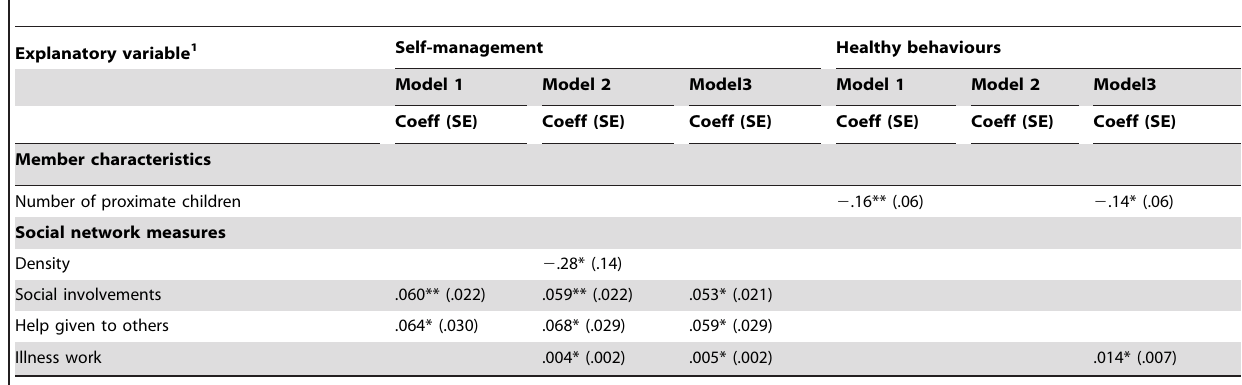
Table 3. Summary of regression analyses of outcomes at Time 1: Self-management